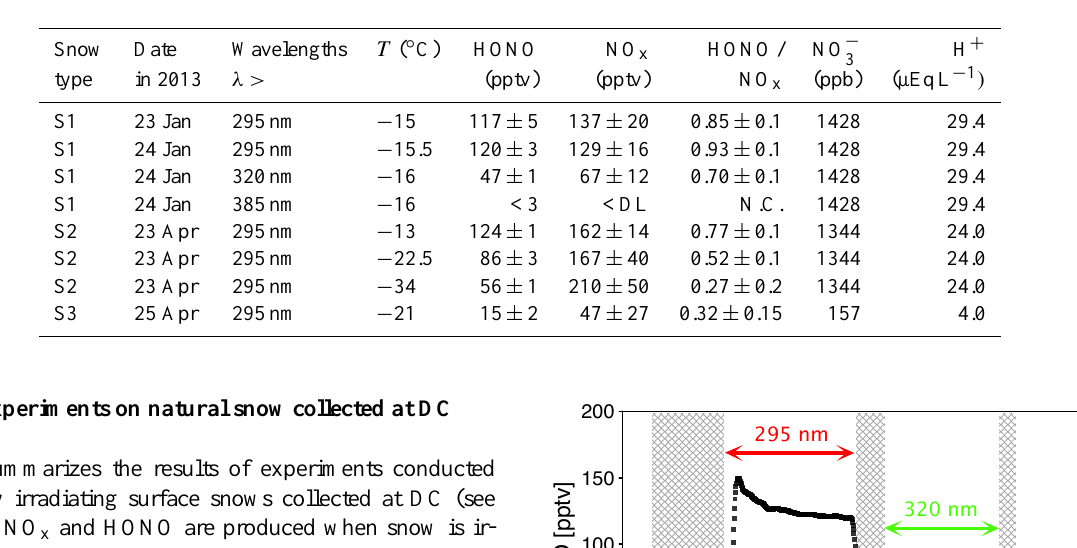
Table 1. Results of irradiation experiments performed at the BAS laboratory on three different surface snows collected at DC. S1 and S2 are upper surface snows collected between 0 and 1 cm; S3 is the surface snow collected between 0 and 12 cm depth. The acidity is calculated by checking the balance between anions and cations (see Sect. 2.2). DL refers to detection limit, and N.C. means non-calculated value.